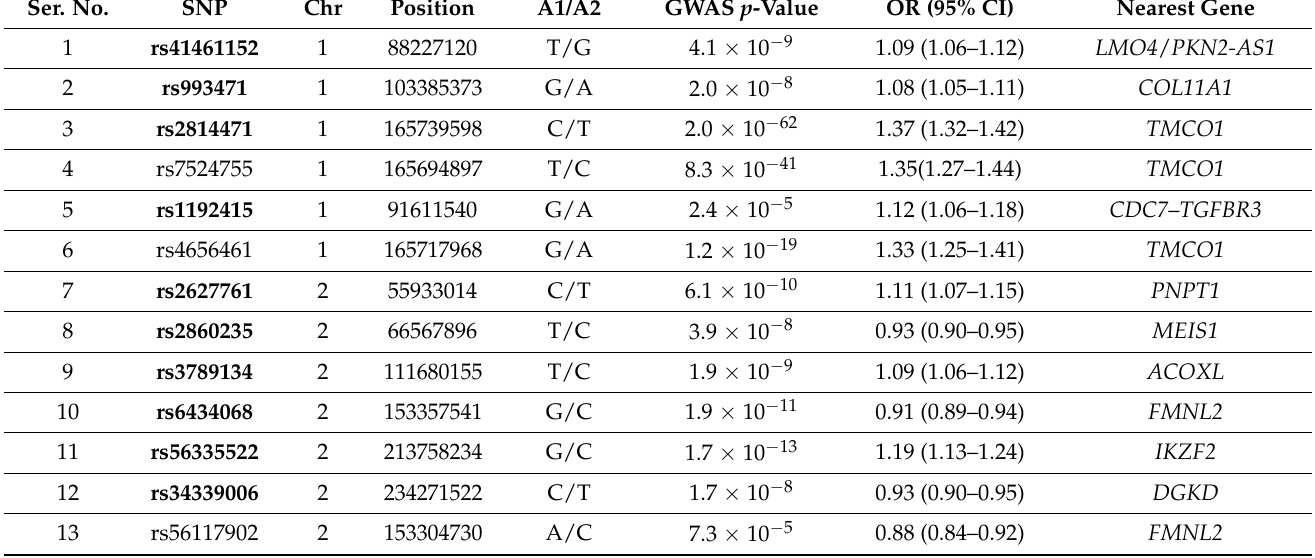
Table 1. Lead POAG gSNPs as reported by Choquet et al.